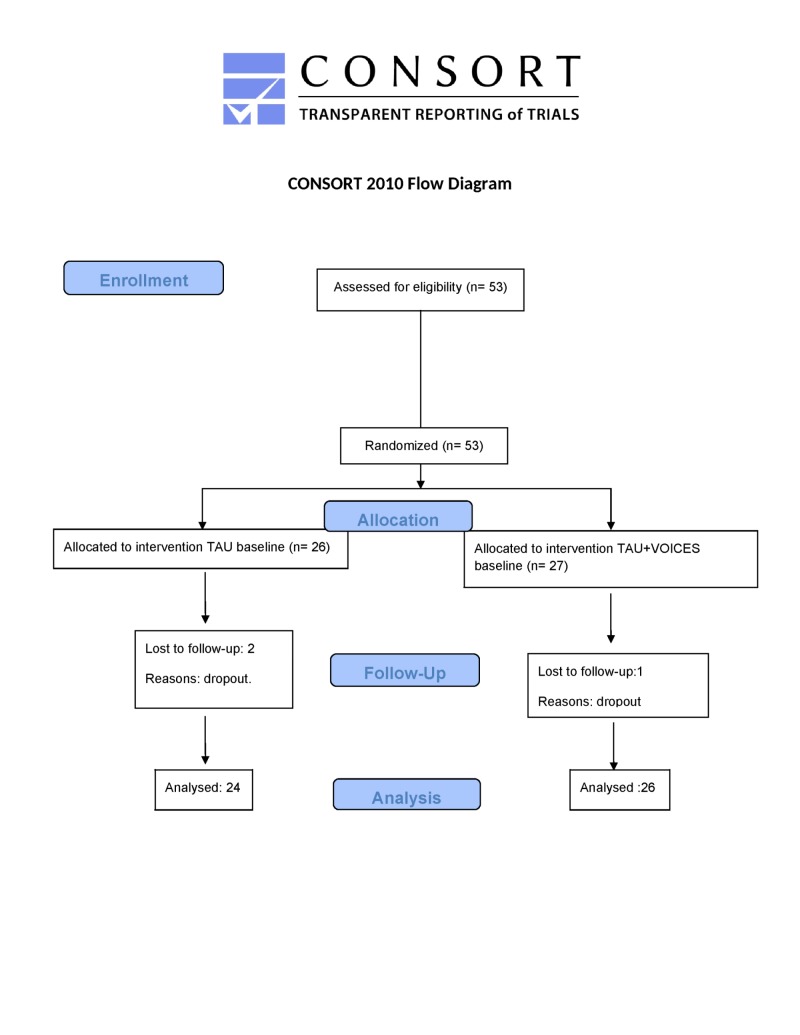
CONSORT flowchart.